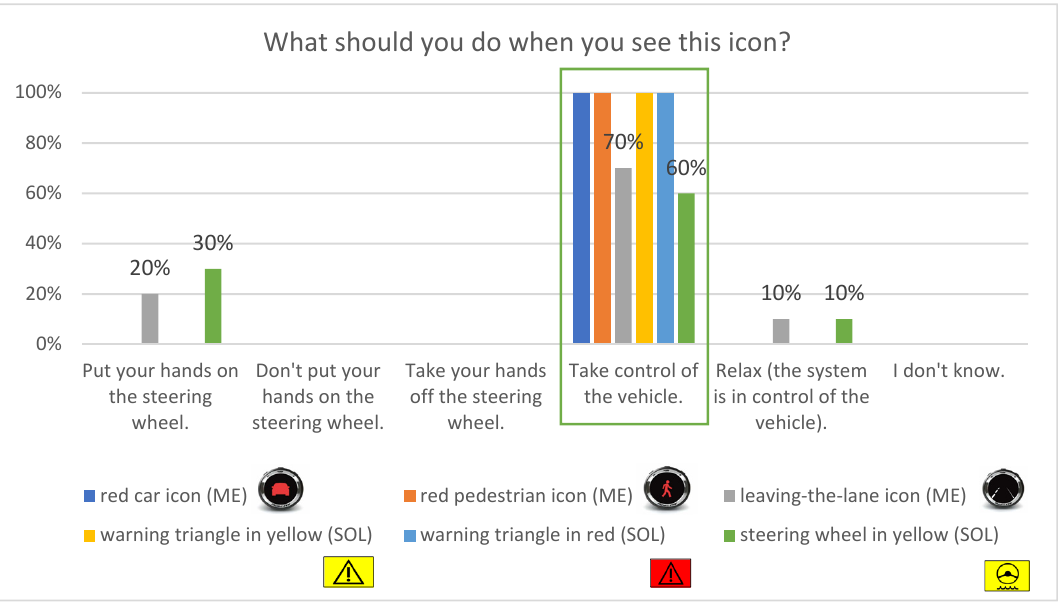
Figure 6. Comprehension Test, assessing the level of understanding of the message conveyed by the icons (“What should you do when you see this icon?”).